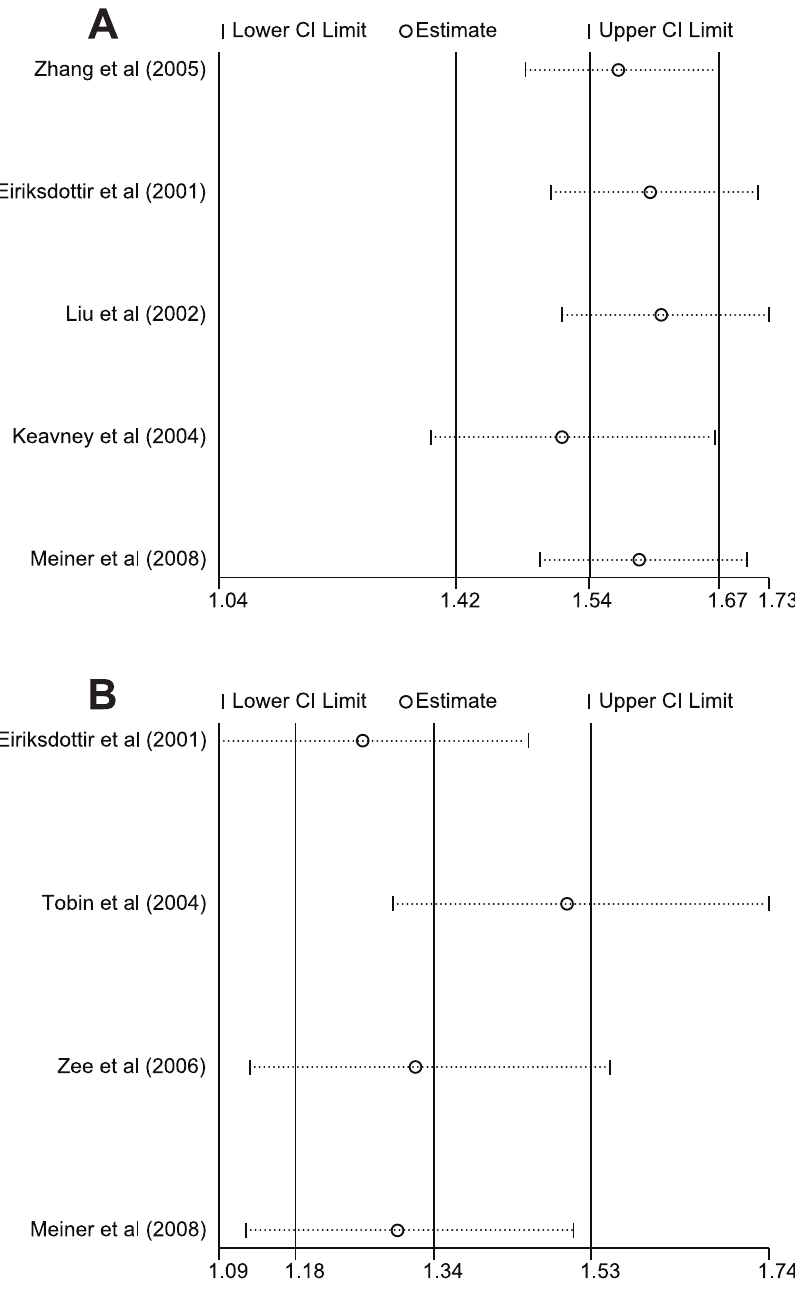
Figure 5. Sensitivity analysis of the relationships of CETP rs708272 (C . T) and rs1800775 (C . A) polymorphisms with myocardial infarction